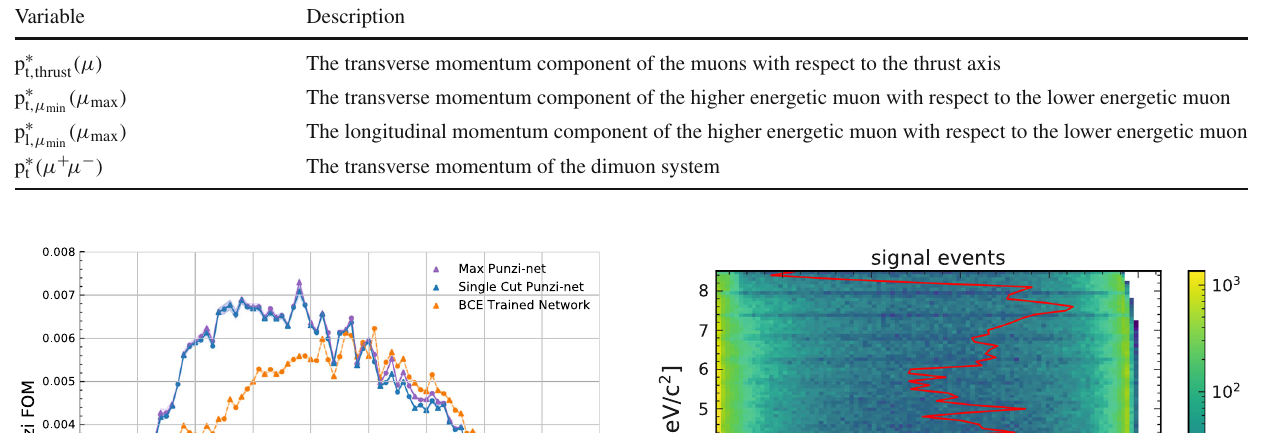
Table 1 The most important features found after training BDTs with many variables. All variables are computed in the centre-of-mass system of the e + e − collisions. These features are used for training the NN Variable